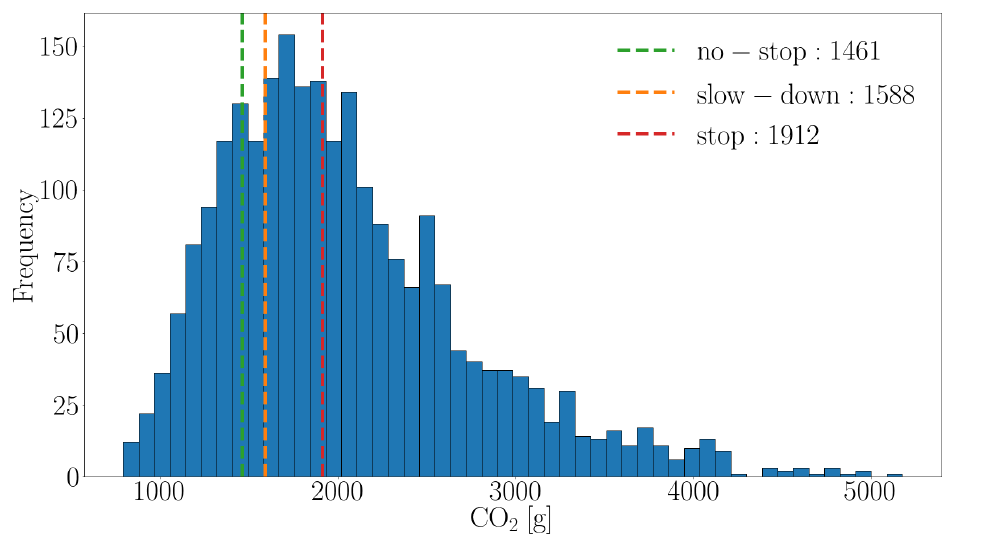
Figure 6. Distribution of the CO 2 emitted on the 2km passage. In green, amber, and red the median values for the no-stop, slow-down, and stop clusters, respectively. The distribution is skewed, and many values of emitted CO 2 occur when interaction with other factors such as traffic is present. This indicates that the gap between the no-stopping vehicle and a vehicle that stops can